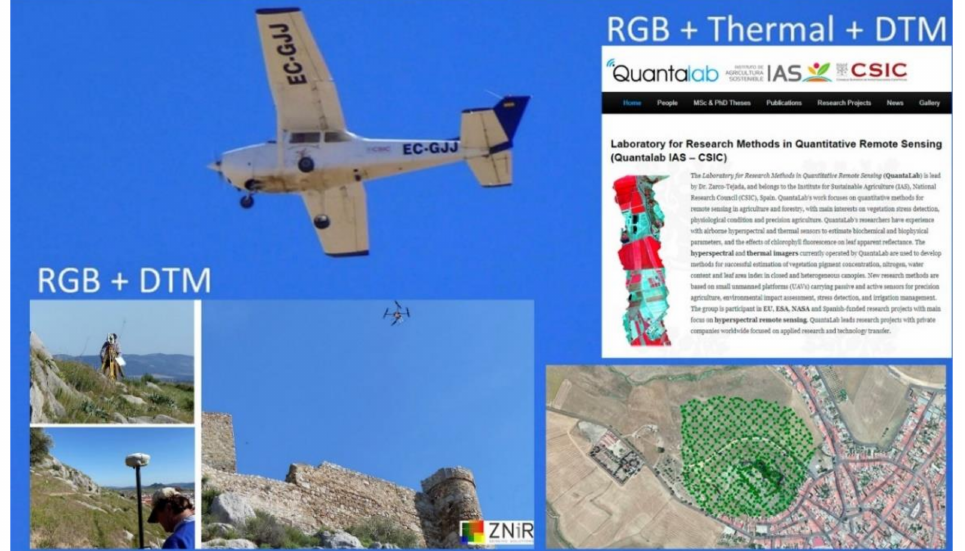
Figure 3. Ortophotogrammetric acquisition survey of the area surrounding the CCB and the medieval Castle of Belmez, performed by aircraft and drone with RGB and thermal sensors. Images from Quantalab-IAS / CSIC and ZNIR for “Ager Mellariensis” / AEI FEDER HAR